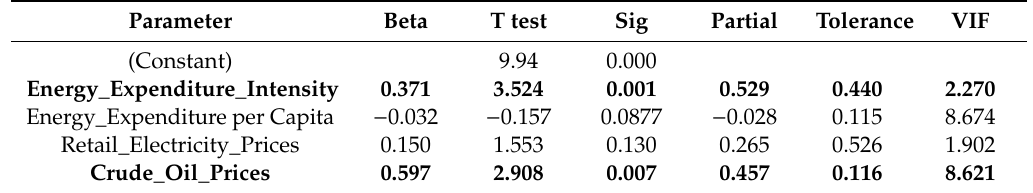
Table 8. Multicollinearity and partial correlation of parameters from the Energy Expenditure group.